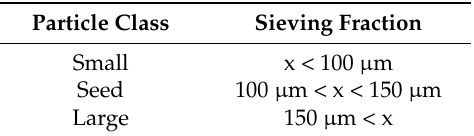
Table 3. Sieving fractions for